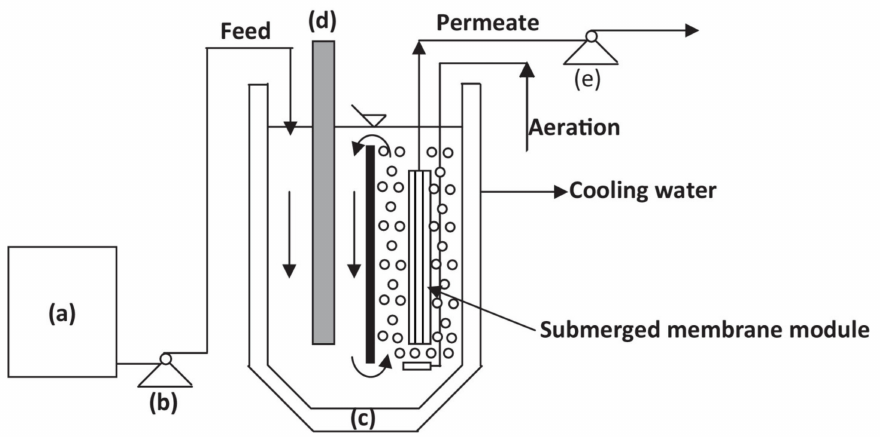
Figure 4. Schematic diagram of the SMPR system: ( a ) feed tank; ( b ) feed pump; ( c ) thermostatic jacket photoreactor; ( d ) UV lamp; ( e ) suction pump (elaborated from